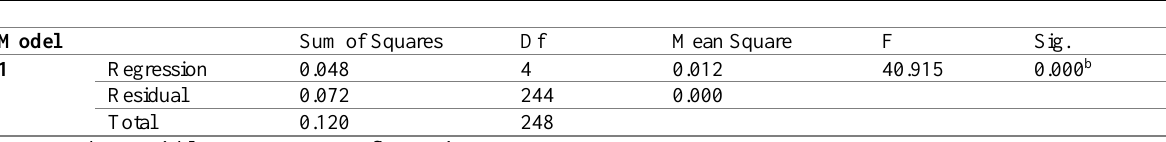
Table 12: ANOVA a